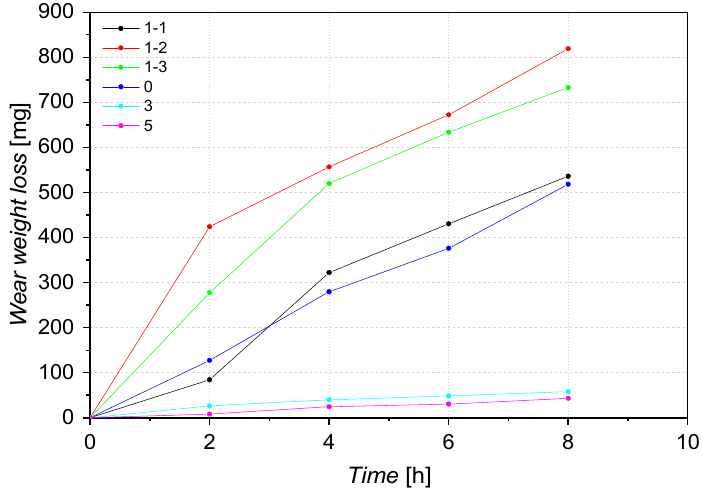
Figure 8. Weight loss of samples as a function of time.